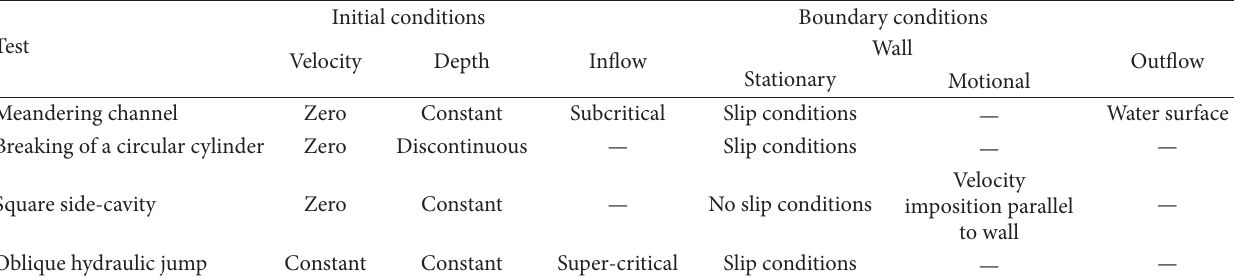
Table 2: Initial and boundary conditions for benchmark test problems considered in this